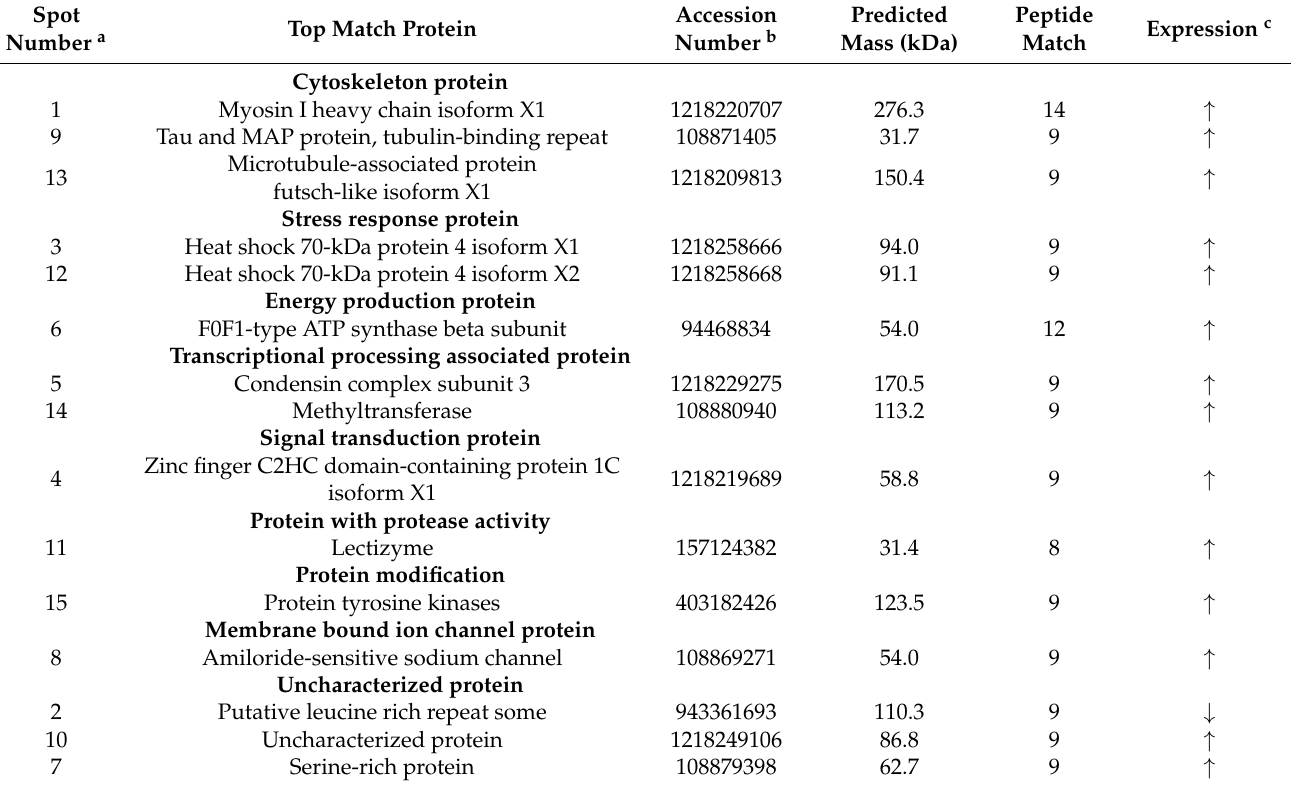
Table 3. Identification of differentially regulated proteins between control (ddH 2 O) and Ag/AgCl NP treatment groups. Database searches using the Mascot program against A. aegypti protein